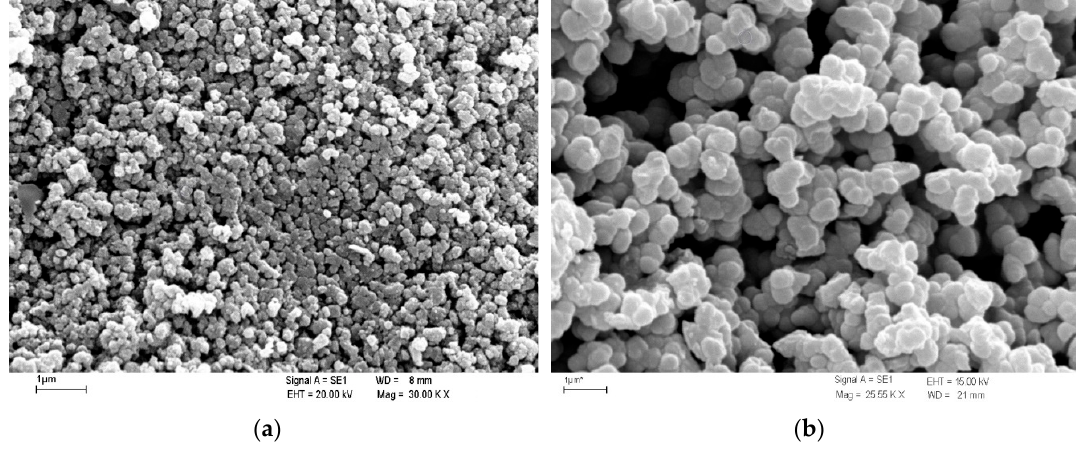
Figure 2. The newborn MnO x clusters on the chalcedonite surface: ( a ) thermally bonded [120] and ( b ) chemically bonded [130]. Reprinted with permission from Ref. [120,130].